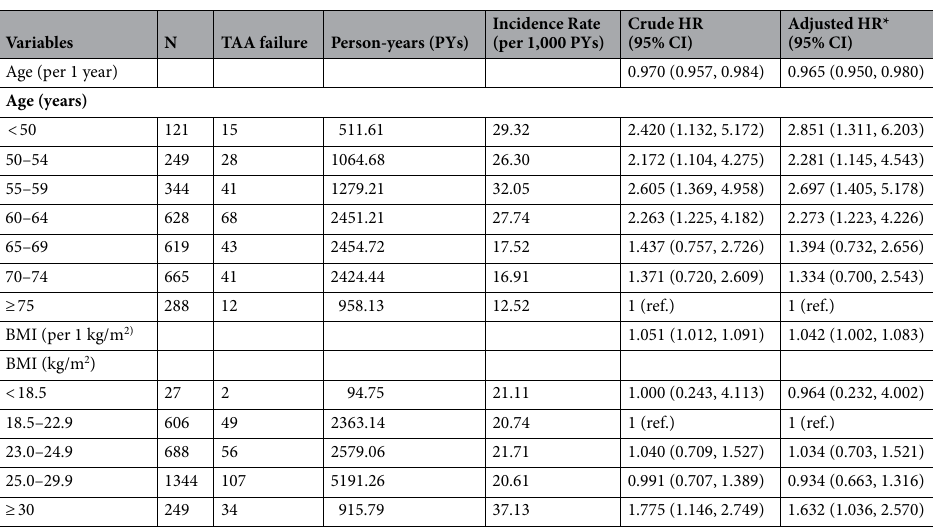
Table 2. Age, BMI, and the risk of TAA failure. *Adjusted for age, sex, BMI, hospital volume, income, diabetes mellitus, hypertension, dyslipidemia, and health-related behaviors (physical activity, smoking, and alcohol). BMI, body mass index; TAA, total ankle arthroplasty; HR, hazard ratio; 95% CI 95% confidence